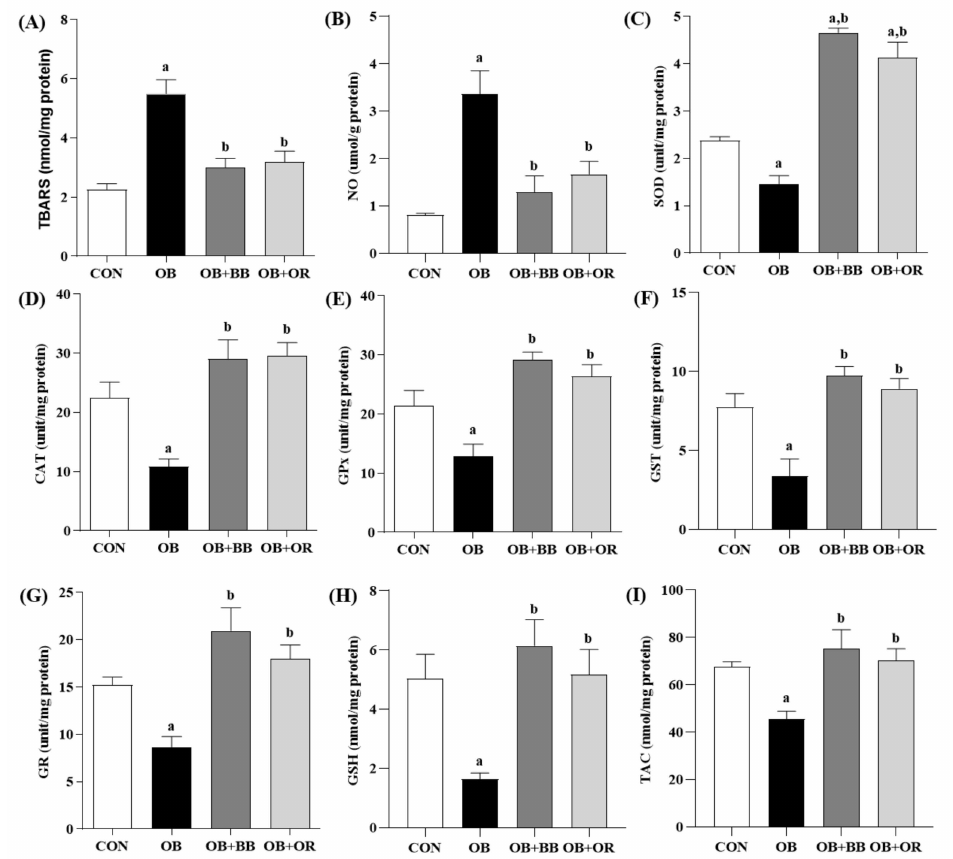
Figure 3. Effect of bee bread on liver oxidant–antioxidant parameters of rats in all experimental groups. ( A ) TBARS, ( B ) NO, ( C ) SOD, ( D ) CAT, ( E ) GPx, ( F ) GST, ( G ) GR, ( H ) GSH and ( I ) TAC in the liver of obese rats. Values are presented as mean ± SEM, n = 8/group. CON, control; OB, obese; OB + BB, obese + bee bread 0.5 g/kg body weight/day; OB + OR, obese + orlistat 10 mg/kg body weight/day; TBARS, thiobarbituric acid reactive substances; NO, nitric oxide; SOD; superoxide dismutase; CAT; catalase; GPx, glutathione peroxidase; GST, glutathione S-transferase; GR; glutathione reductase; GSH, total glutathione; TAC; total antioxidant capacity. One-way ANOVA, followed by Tukey post-hoc test. a p < 0.05 vs. CON group, b p < 0.05 vs. OB